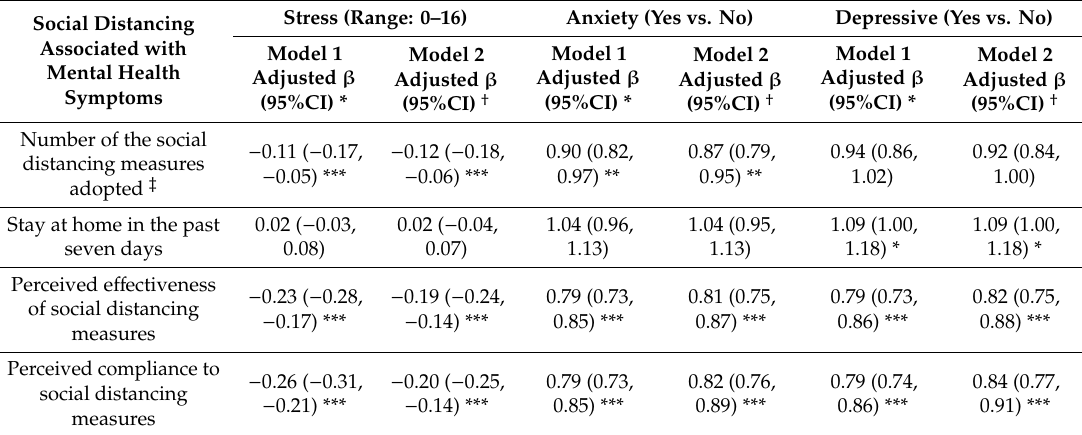
Table 4. Association of mental health symptoms with social distancing